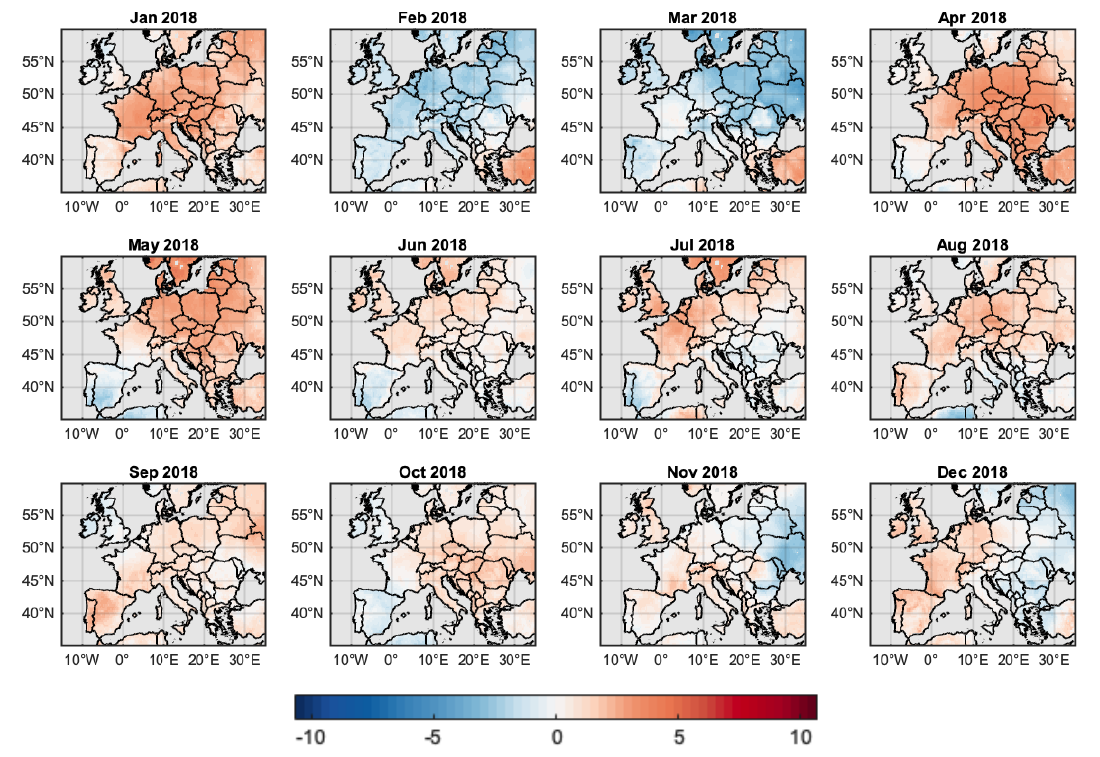
Figure 9. As in Figure 3 but considering T2m from ERA5 for 2004 – 2019. The number of months in 2018 with monthly T2m corresponding to the highest anomaly in the common period is shown in Figure 10. Record-breaking T2m anomalies were reached in 3 months over wide Northern and Central Europe areas. In the Mediterranean regions, the overall pattern is more scattered with regions where no record-breaking LSTs were measured to areas where it occurred 1–2 months (Figure S2). The spatial pattern obtained when considering the full (40-year) reanalysis period is very similar, despite showing, as expected, relatively smaller areas with three months of record-breaking temperature anomalies. Southern Europe presents a large pattern of almost no record- breaking monthly temperature anomalies.